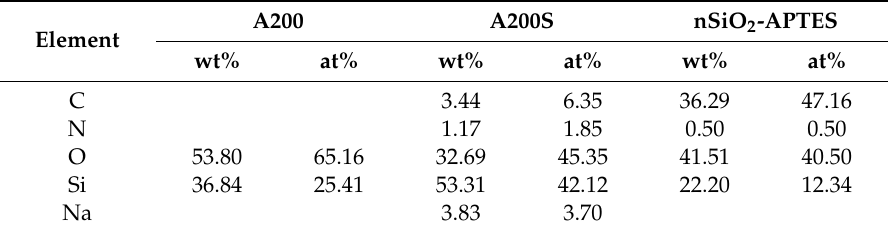
Table 1. Weight and atomic percentage of A200, A200S and nSiO 2 -APTES S NPs by EDS analysis.